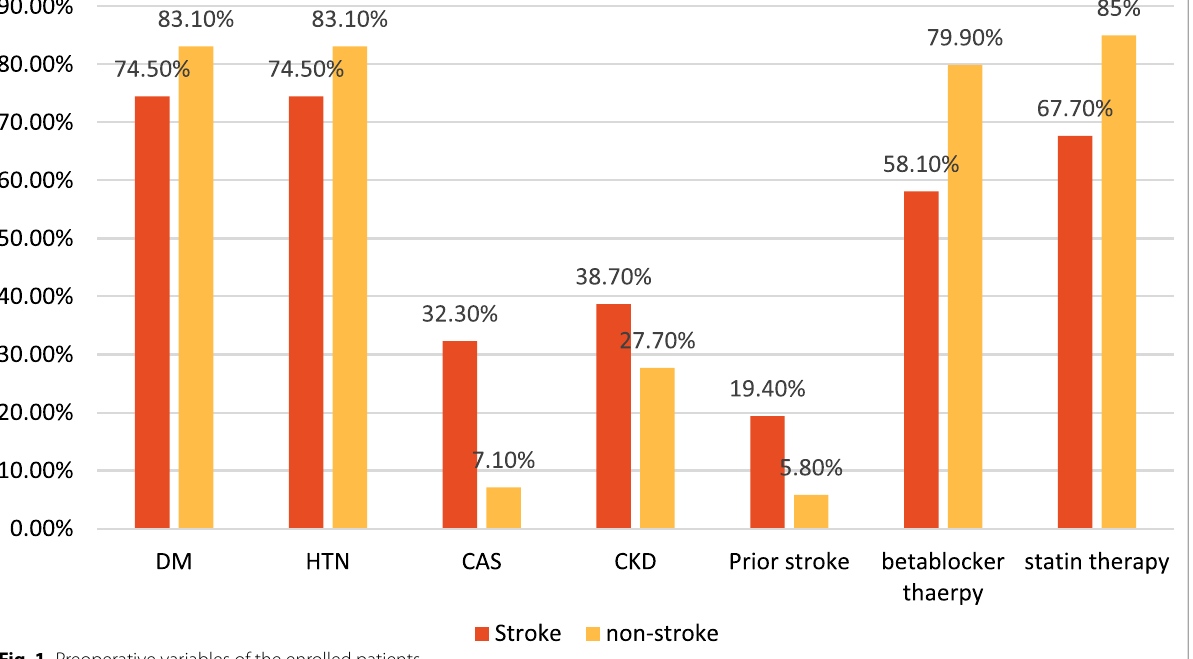
Fig. 1 Preoperative variables of the enrolled patients